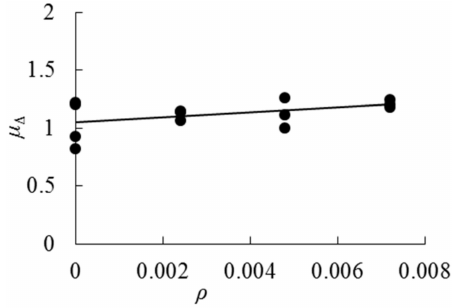
Figure 12. Ductility factor–cloth ratios trend curve.